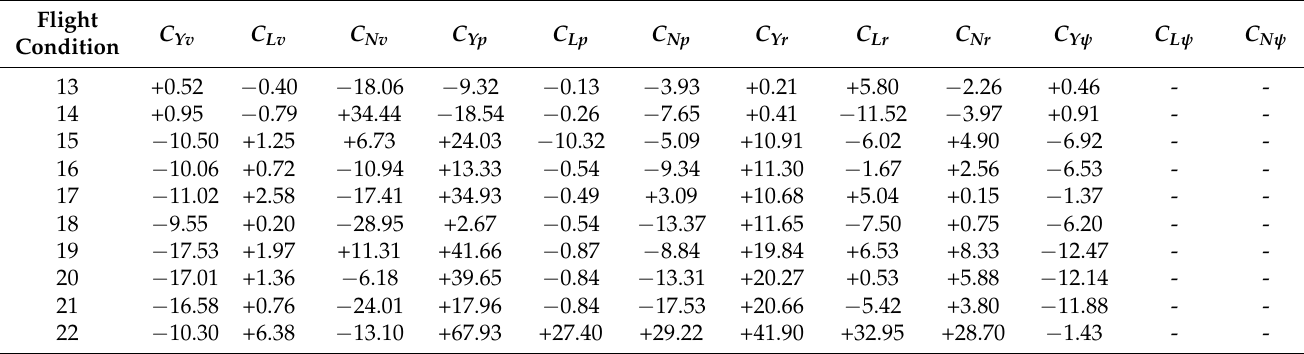
Table 32. Relative accuracy of takeoff lateral stability derivatives (percentage discrepancy % between extrapolation and